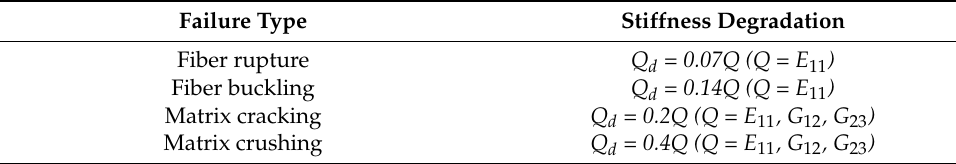
Table 6. Camanho degradation